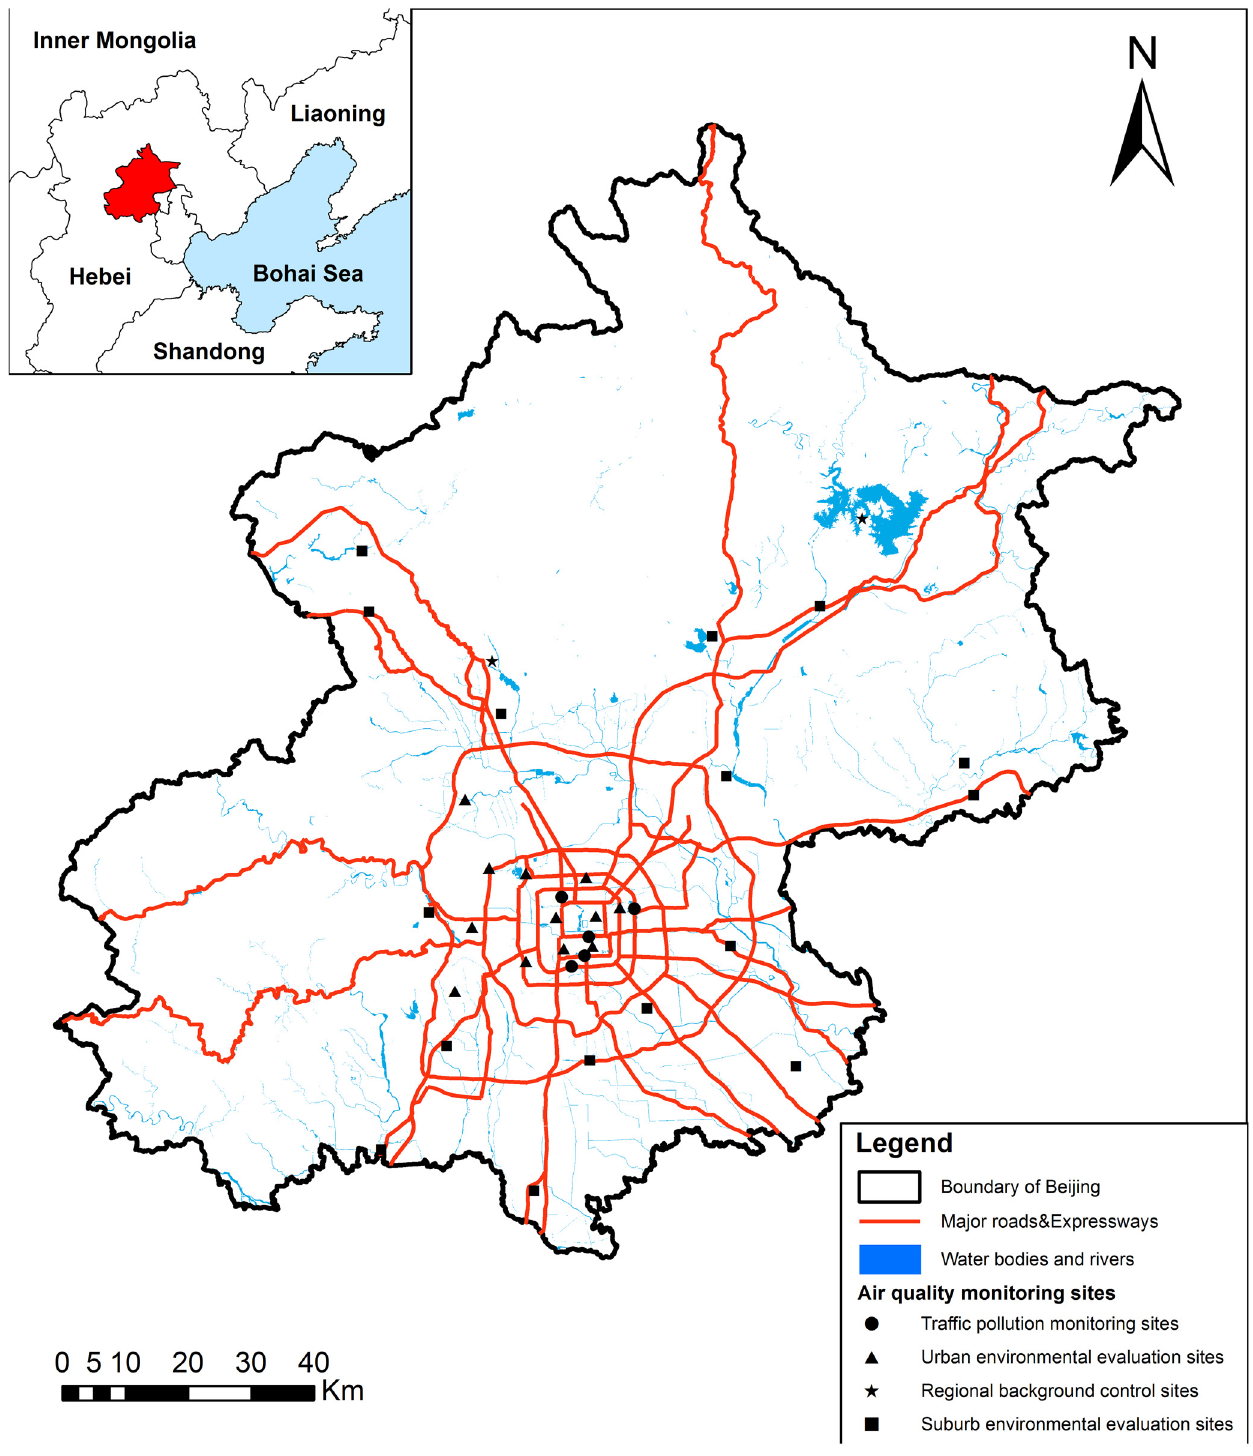
Fig 1. Classification and distribution of air quality monitoring sites in Beijing.